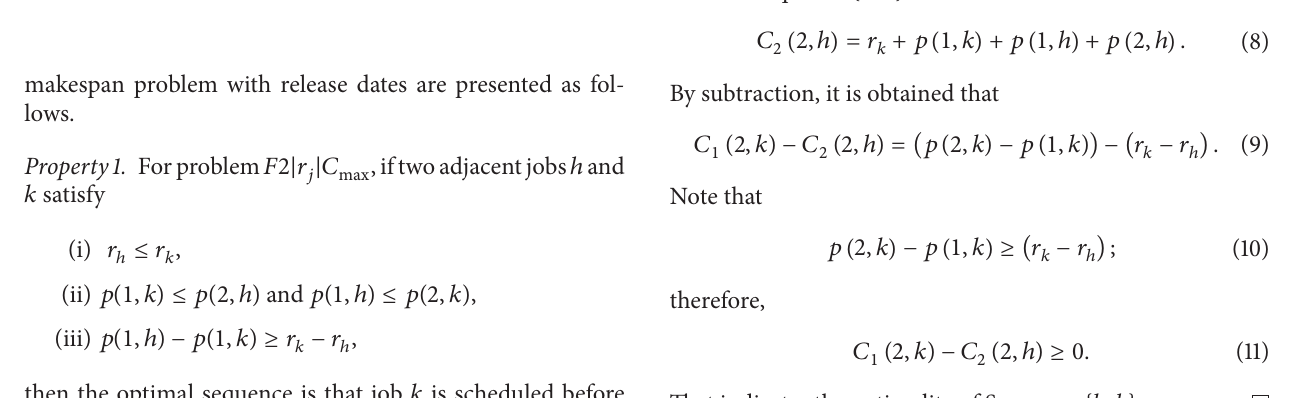
Figure 2: The schedule of the MGS algorithm in Example 1.